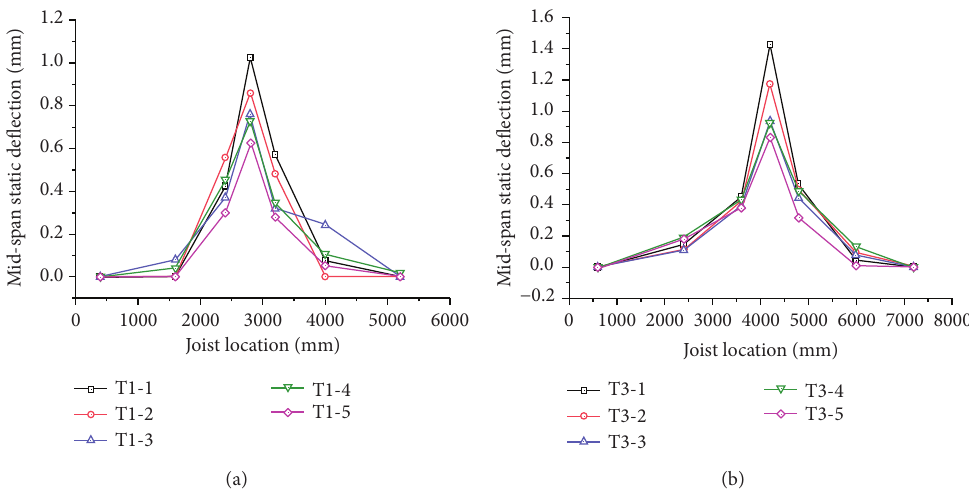
Figure 8: Midspan static deflections of the test floors before and after installation of strongbacks under the concentrated load of 1kN at the floor center.